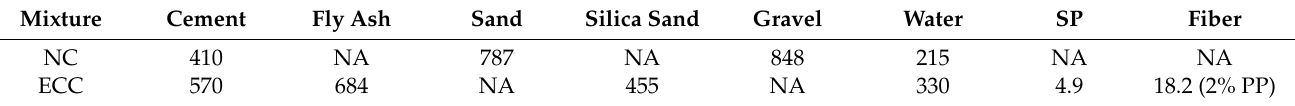
Table 1. Material contents in the ECC and NC mixtures (kg/m 3